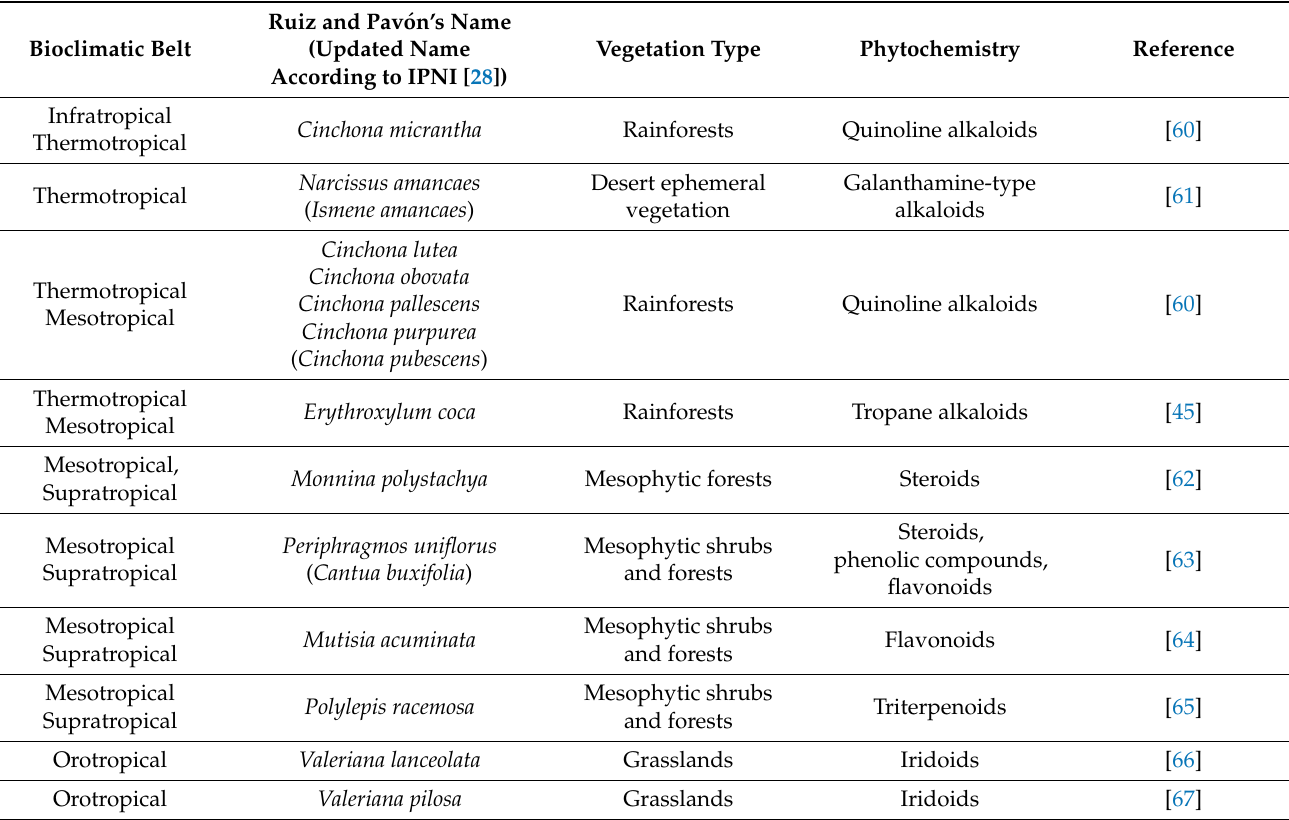
Table 2. Correspondence between bioclimatic belts, vegetation and phytochemistry of some species of the